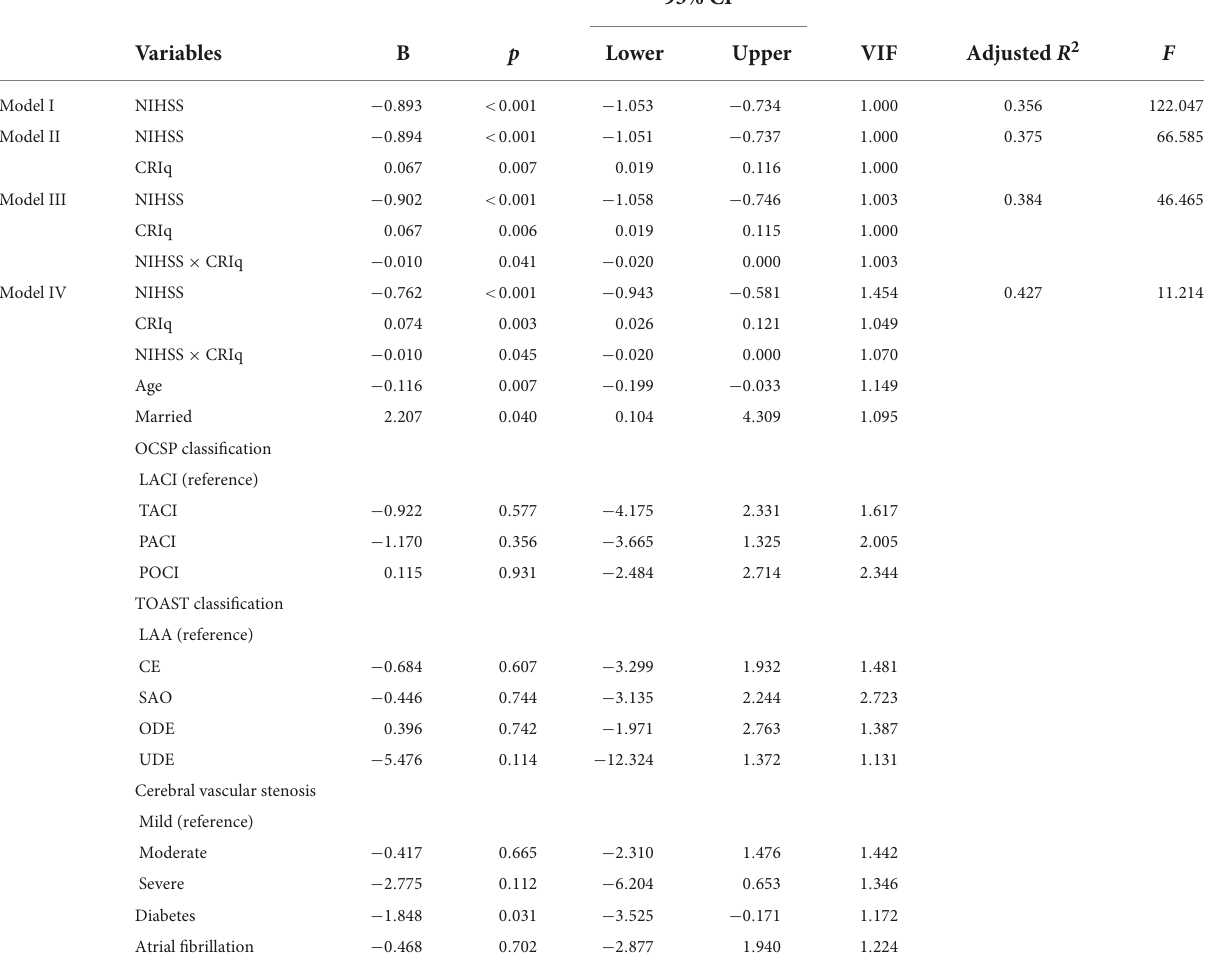
TABLE 2 Moderating effect of cognitive reserve on the relationship between stroke severity and cognitive function in patients with